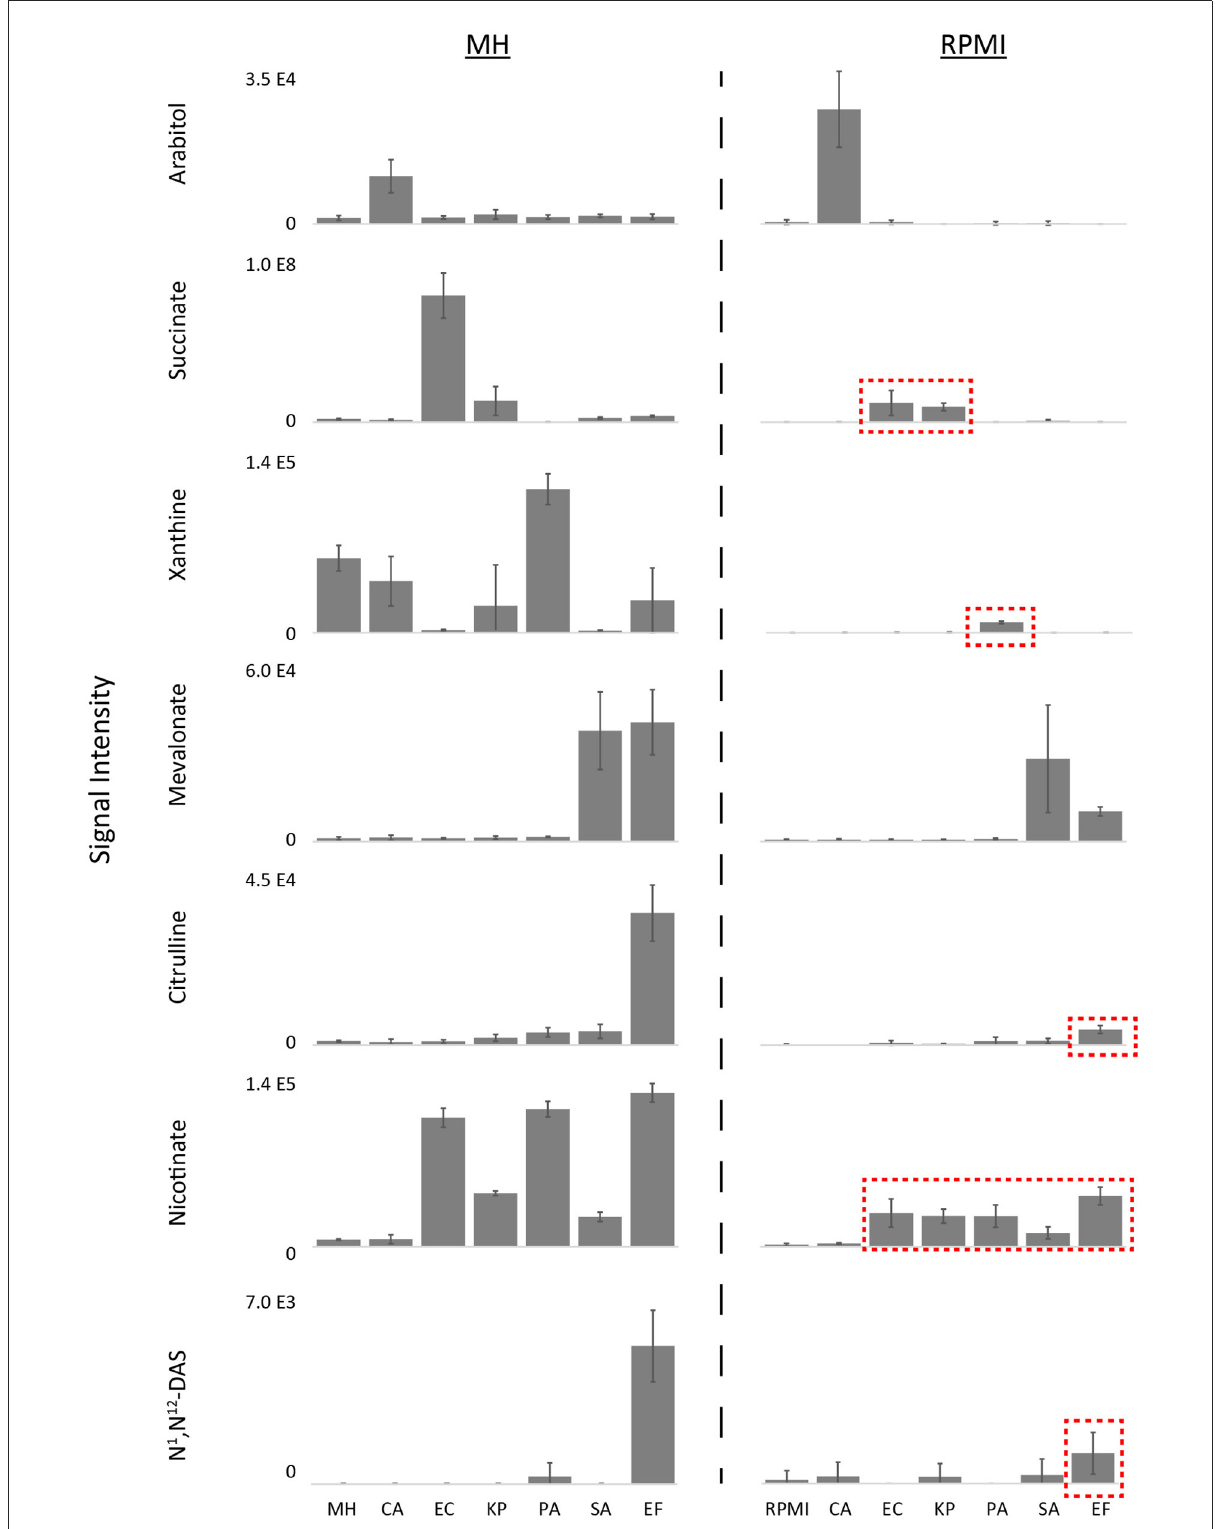
FIGURE3 Differential biomarker production of pathogens incubated in MH vs.RPMI medium. While most production biomarkers were observed on MH and RPMI, levels of succinate, xanthine, citrulline, and nicotinate were significantly lower on RPMI, and N 1 ,N 12 -diacetylspermine production on RPMI did not meet diagnostic thresholds (Source Data File 3). Key biomarkers that are affected by medium have been highlighted in red boxes. MH, Mueller Hinton medium; RPMI, Roswell Park Memorial Institute medium; CA , Candida albicans ; KP , Klebsiella pneumoniae ; EC, Escherichia coli ; PA , Pseudomonas aeruginosa ; SA , Staphylococcus aureus ; EF, Enterococcus faecalis . Data are presented as mean values + / − SD of n = 4